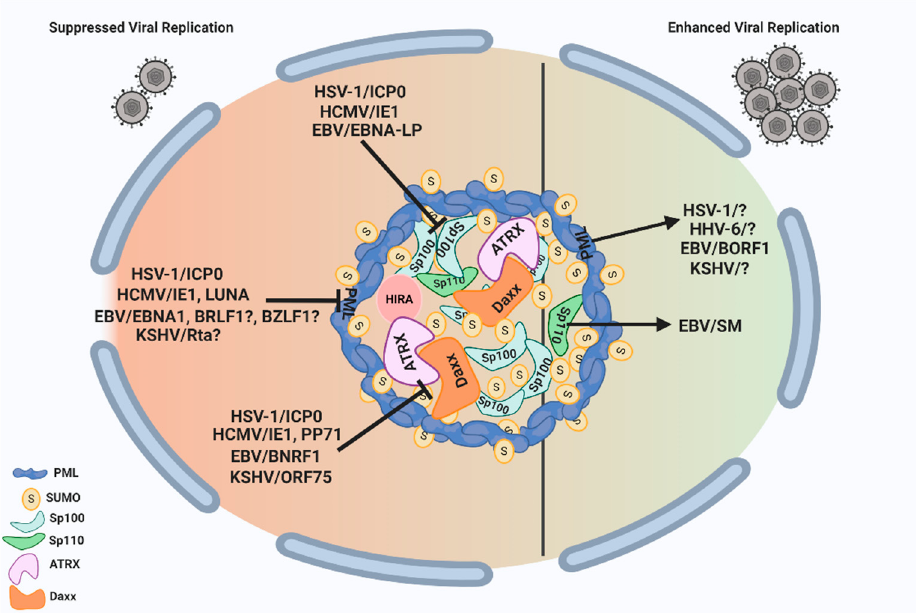
Figure 2. ND10 nuclear bodies serve as multifunctional nuclear hubs with both pro- and anti-viral outcomes. On the one hand, ND10 nuclear bodies mediate intrinsic and innate immune responses to herpesvirus infection through some of their residents such as PML, Daxx/ATRX, and Sp100. All subfamilies of human herpesviruses express proteins that counteract these suppressive functions of ND10. These viral proteins are listed on the left side of the figure, and their specific targets are indicated by the block signs. On the other hand, herpesviruses have evolved to benefit from some of the ND10 proteins as well. The proteins that can improve herpesvirus replication are indicated by the arrows pointing to their specific target viruses on the right side of the figure. The unknown viral proteins involved in the pro-viral interactions or viral proteins with a possible role in antagonizing ND10 are indicated by question marks in the figure. This figure was created with BioRender.com.